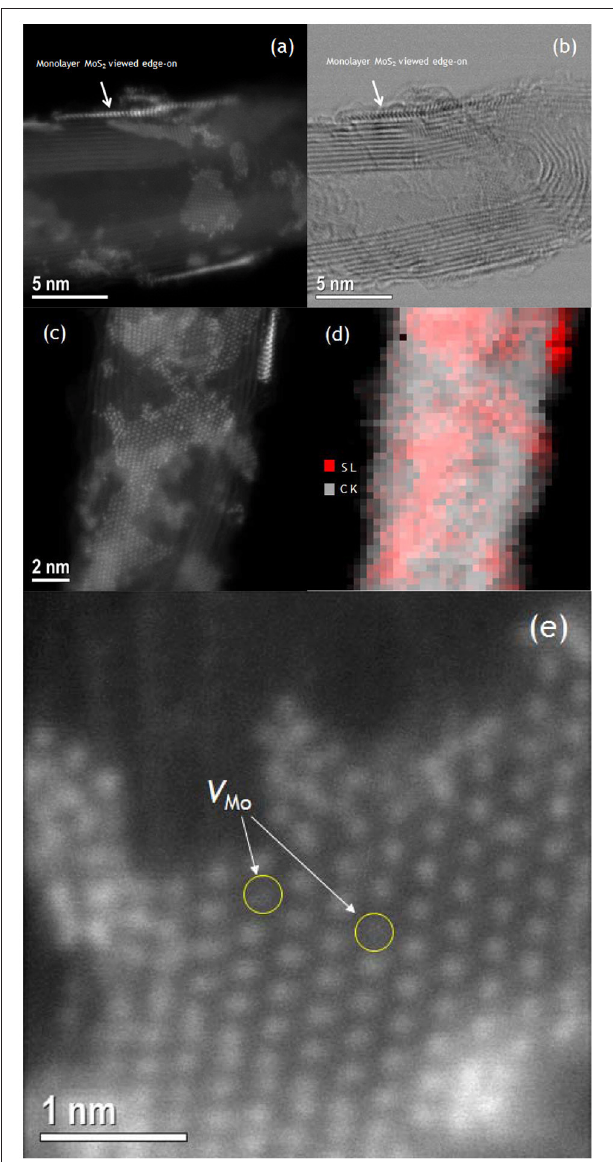
FIGURE 7 | Z-contrast STEM images (a,c) , bright field image (b) and EELS sulfur and carbon elemental mapping (d) , (with red and gray colors representing sulfur and carbon, respectively), of MoS 2 /CN composites. Z-contrast image of monolayer MoS 2 on CN showing individual Mo vacancies (e)